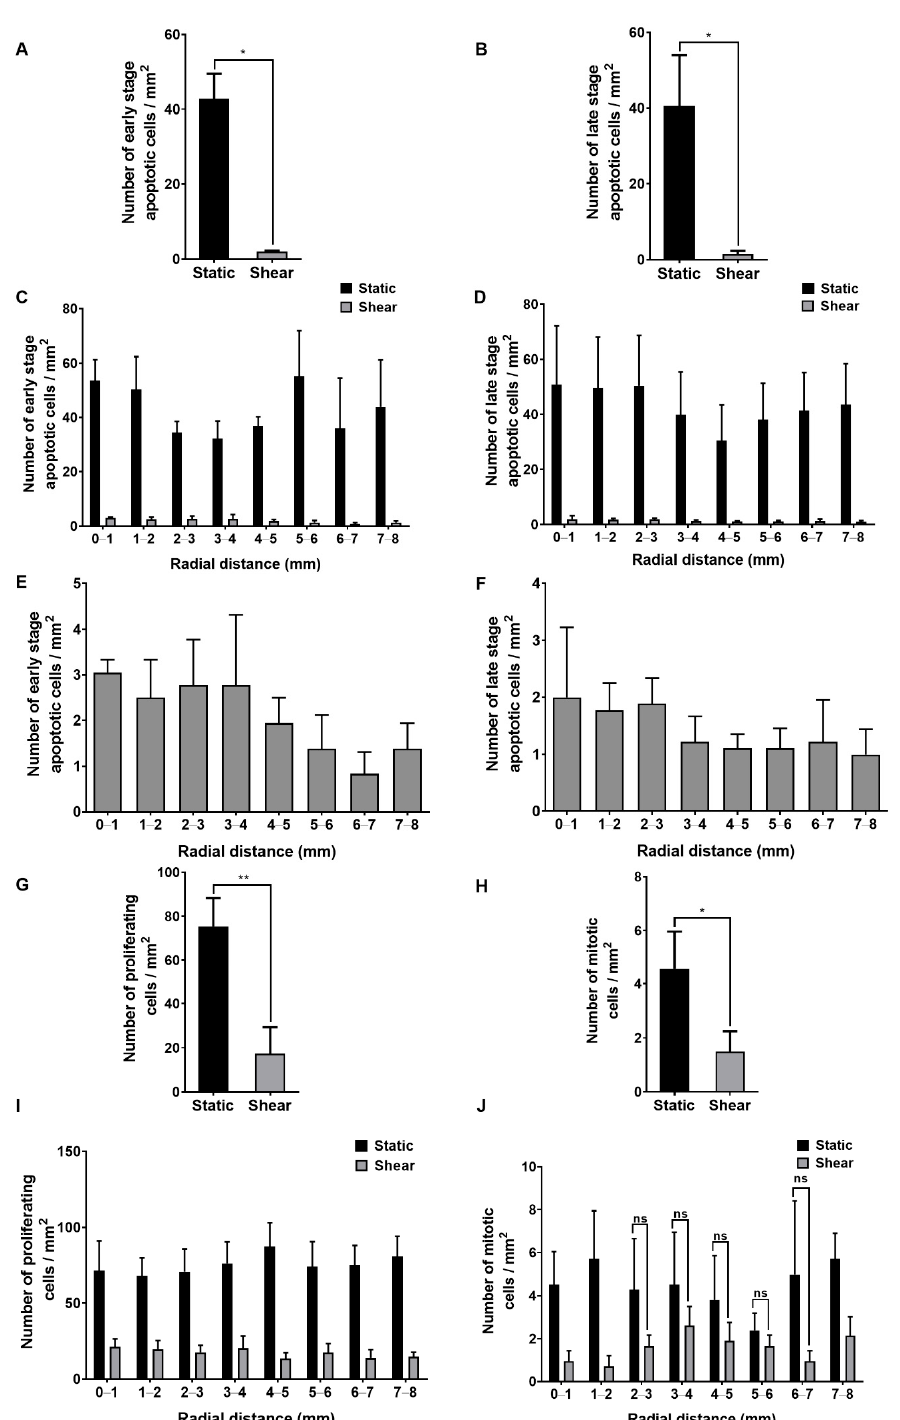
Figure 2. Frequency of endothelial cells in ( A ) early- and ( B ) late-stage apoptosis averaged across the entire well for static and sheared monolayers. There were approximately 750 cells/mm 2 on the base of the well. Frequency of ( C ) early-and ( D ) late-stage apoptotic cells as a function of radial distance from the centre of the well under both conditions. Sheared results from ( C , D ) are presented on an expanded scale in ( E , F ), respectively. Frequency across the entire well of ( G ) proliferating and ( H ) mitotic cells under static conditions and shear. Frequency at different radial distances from the well centre of ( I ) proliferating and ( J ) mitotic cells under both conditions. Effects of shear were significant at all radial locations for ( C , D , I ) and, unless otherwise indicated, in ( J ). Mean ± SEM, n = 5